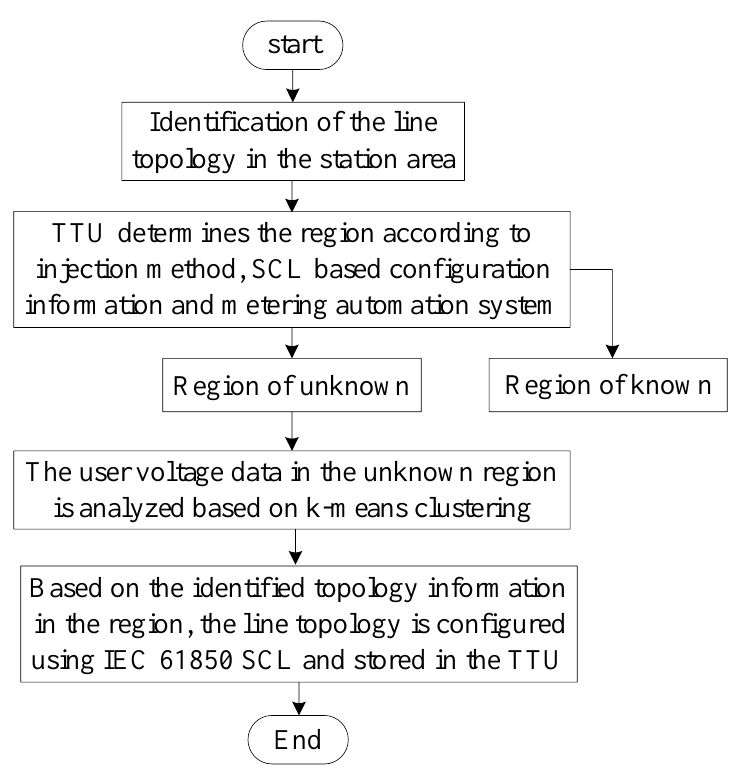
Figure 7. General flow chart of topology identification strategy.